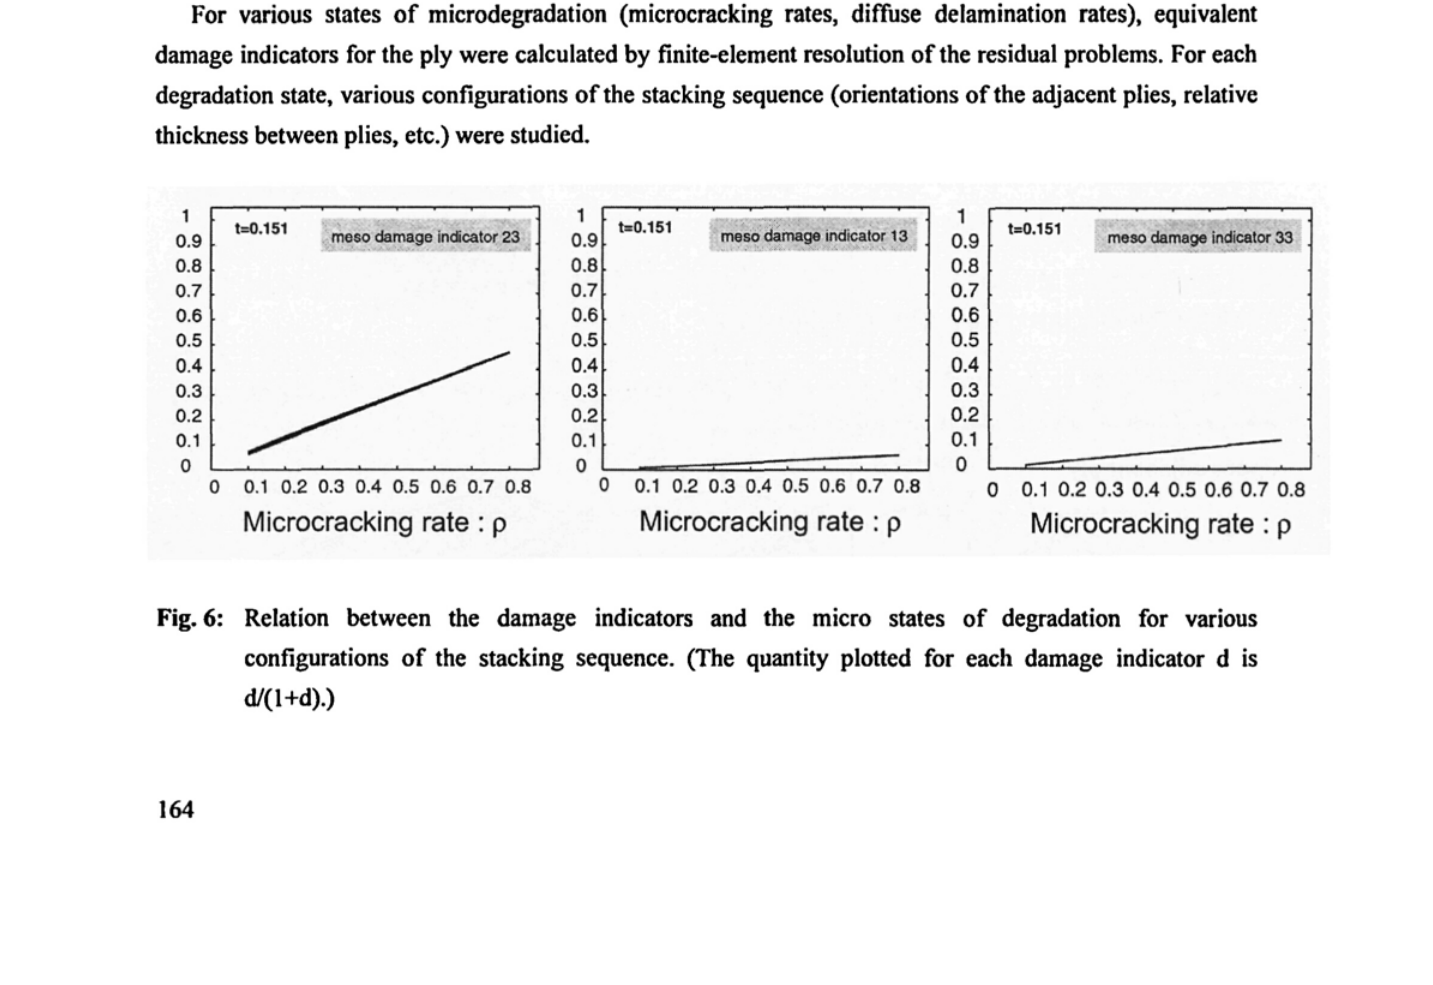
Fig. 6: Relation between the damage indicators and the micro states of degradation for various configurations of the stacking sequence. (The quantity plotted for each damage indicator d is